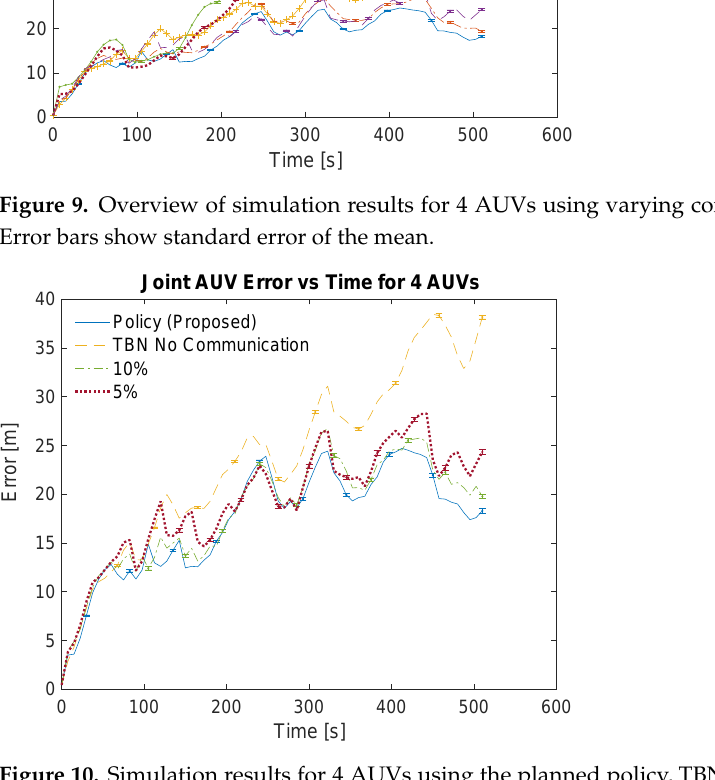
Figure 10. Simulation results for 4 AUVs using the planned policy, TBN without communication, and low bandwidth communication policies. Error bars show standard error of the